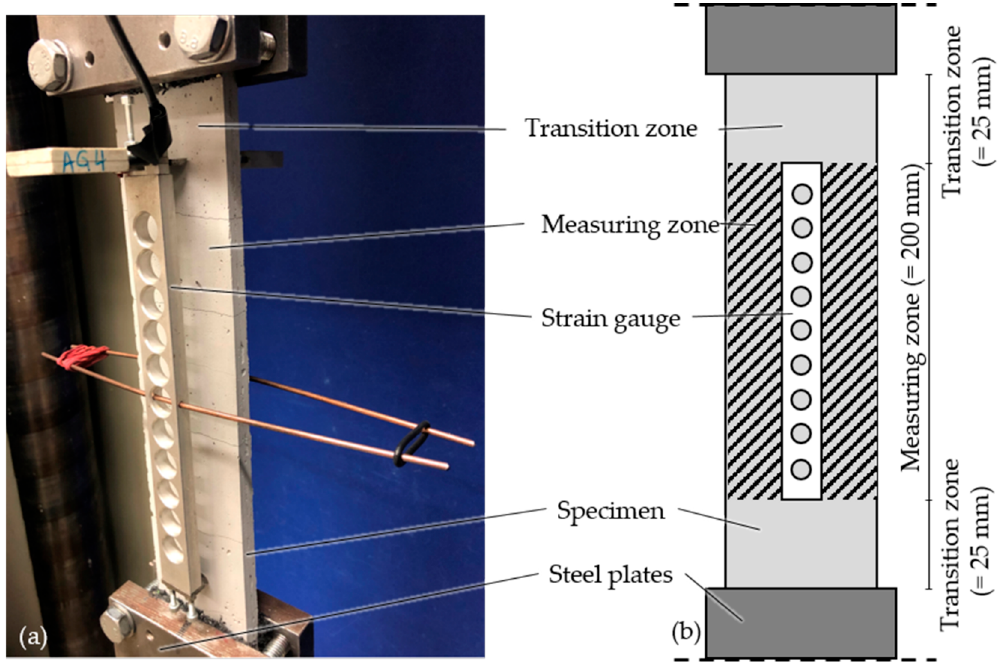
Figure 5. Representation of the tensile test setup used in this work: ( a ) picture; ( b ) schematic representation.